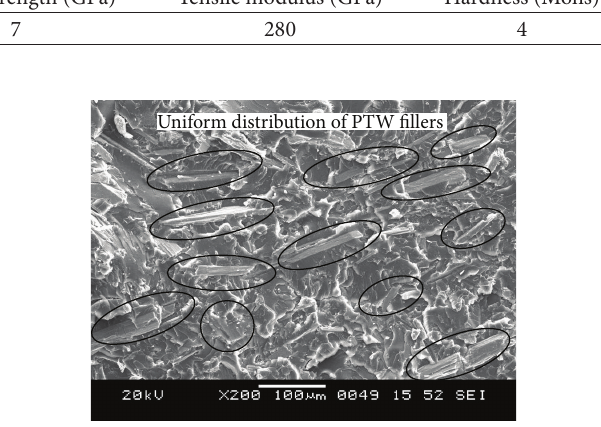
Figure 3: SEM picture of 15% PTW filled